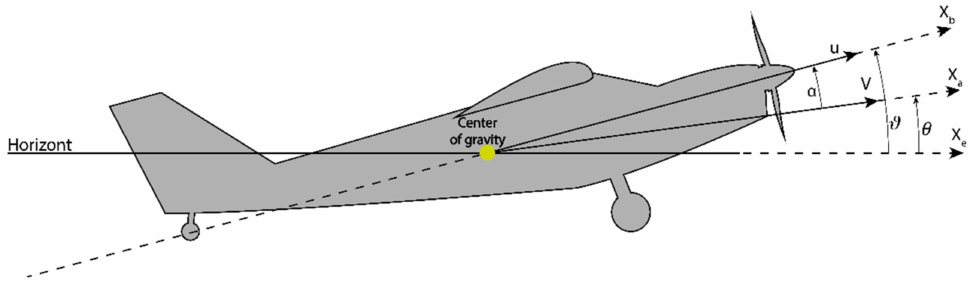
Figure 1. Longitudinal movement of the aircraft.